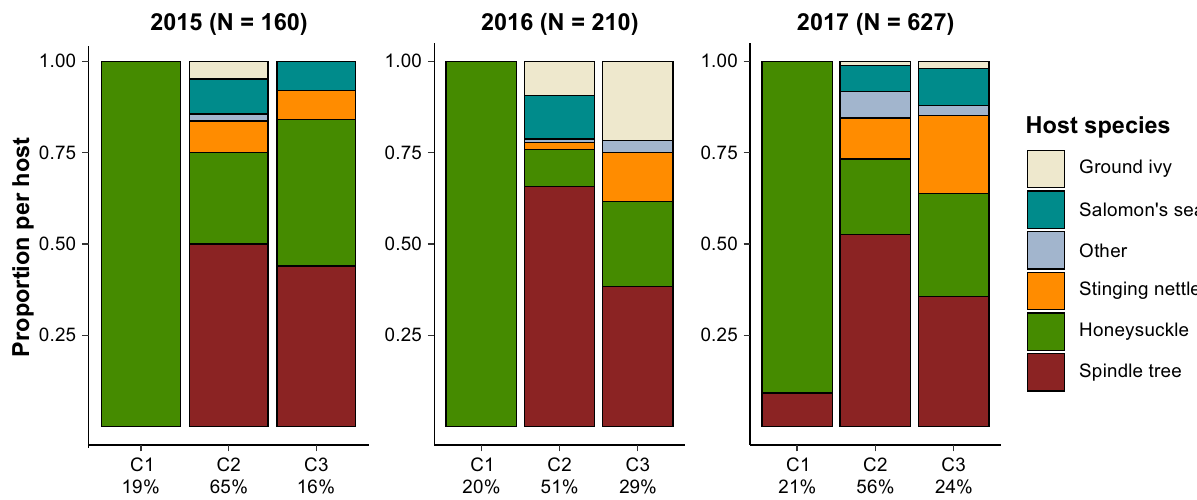
Fig. 1 Associations between Tetranychus urticae cytotypes and host plant species in the dune ecosystem of The Netherlands. Host range of the three most abundant Tetranychus urticae CO1-based cytotypes (C1, C2 and C3) identi fi ed in 2015, 2016 and 2017 (left, middle, and right, respectively). Percentages on the x -axis represent the number of individuals belonging to a cytotype over the total number of individuals ( N ) per year. Proportions on the y -axes represent the number of individuals of a cytotype found on a particular host over the total number of individuals belonging to that cytotype. Host species (legend, far right) are ground ivy ( Glechoma hederacea ), wild honeysuckle ( Lonicera periclymenum ), Salomon ’ s seal ( Polygonatum multi fl orum ), spindle tree ( Euonymus europaeus ), and stinging nettle ( Urtica sp. ). ‘ Other ’ includes blackberry, stalk rose, elderberry, and at least three different host- species that were not taxonomically identi fi